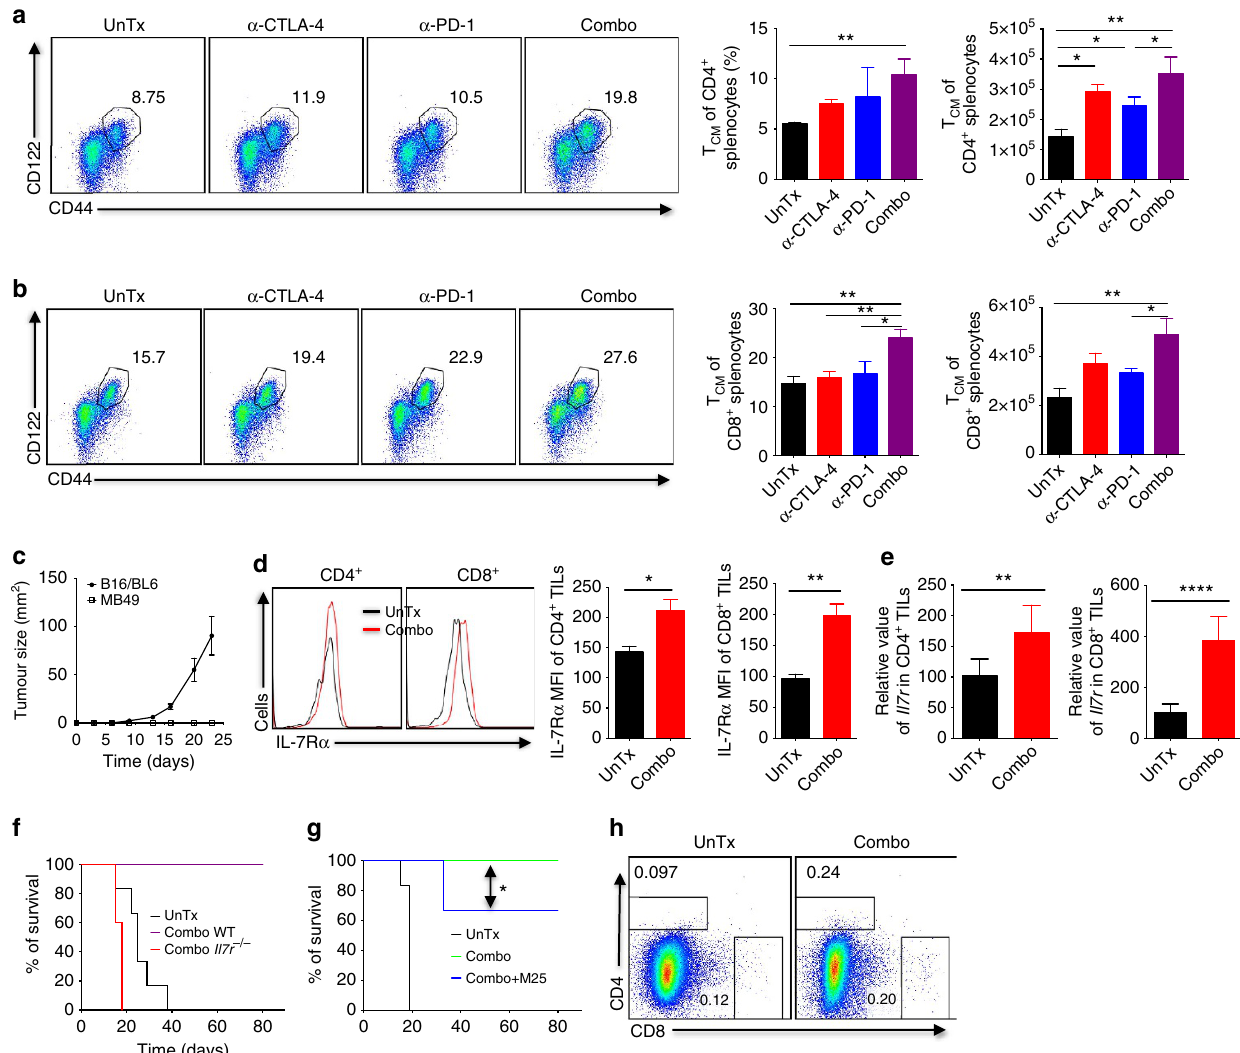
Figure 5 | Combination therapy induces memory response and therapeutic benefits by engaging IL-7 signalling. ( a , b ) Isolated splenocytes from tumour-bearing WT mice with regressing tumours treated with mono- or combo therapy were analyzed for: ( a ) Frequencies of CD4 þ CD44 hi CD122 þ ( T CM ) and ( b ) Frequencies of CD8 þ CD44 hi CD122 þ ( T CM ) cells. Pooled results of percentage and absolute cell number of T CM from five mice are depicted as bar graphs. ( c ) Combo-treated WT mice that previously rejected MB49 tumours were re-challenged with MB49 tumour cells or unrelated B16-BL6 melanoma cells. Tumour growth (mm 2 ) is shown. ( d ) Surface expression of IL-7R a on CD4 þ and CD8 þ TILs as described in Fig. 3 and MFIs of IL-7R a from five mice are presented (right). ( e ) mRNA expression of IL-7R a in sorted CD4 þ and CD8 þ TILs from untreated and combo-treated mice by real-time RT- PCR. Results were normalized to the expression of housekeeping gene ( b -actin ). ( f ) Survival of WT and Il7r (cid:3) / (cid:3) tumour-bearing mice treated with combination therapy. ( g ) Survival of tumour-bearing mice pretreated with blocking antibody against IL-7 (M25) upon combination therapy. ( h ) Abundance of CD4 þ and CD8 þ TILs isolated from Il7r (cid:3) / (cid:3) tumour-bearing mice as described in f . Data are means ± s.e.m. of five mice in each group. NS, no statistical significance; * P o 0.05; ** P o 0.01; *** P o 0.001; **** P o 0.0001 by one-way ANOVA with Bonferroni’s post hoc test ( a , b ), two-tailed unpaired Student’s t -test ( d , e ) or log-rank (Mantel–Cox) test ( g ). Data are representative of two to three independent experiments.